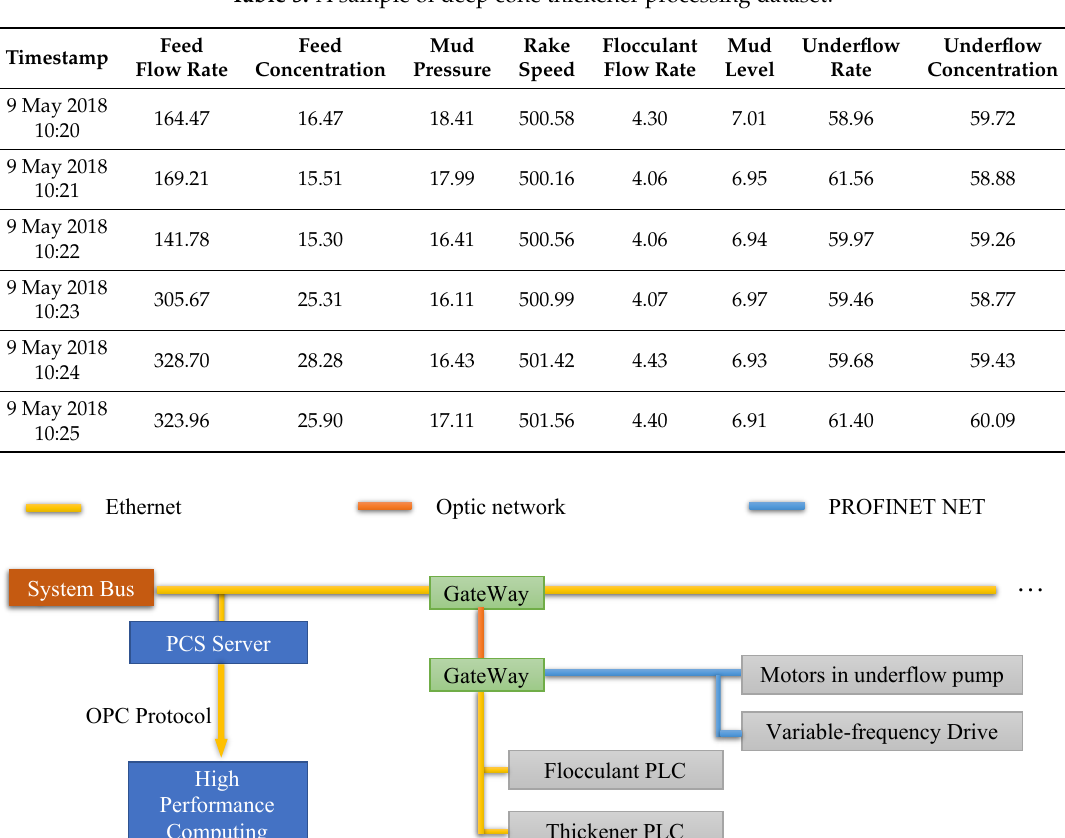
Table 5. A sample of deep cone thickener processing dataset.